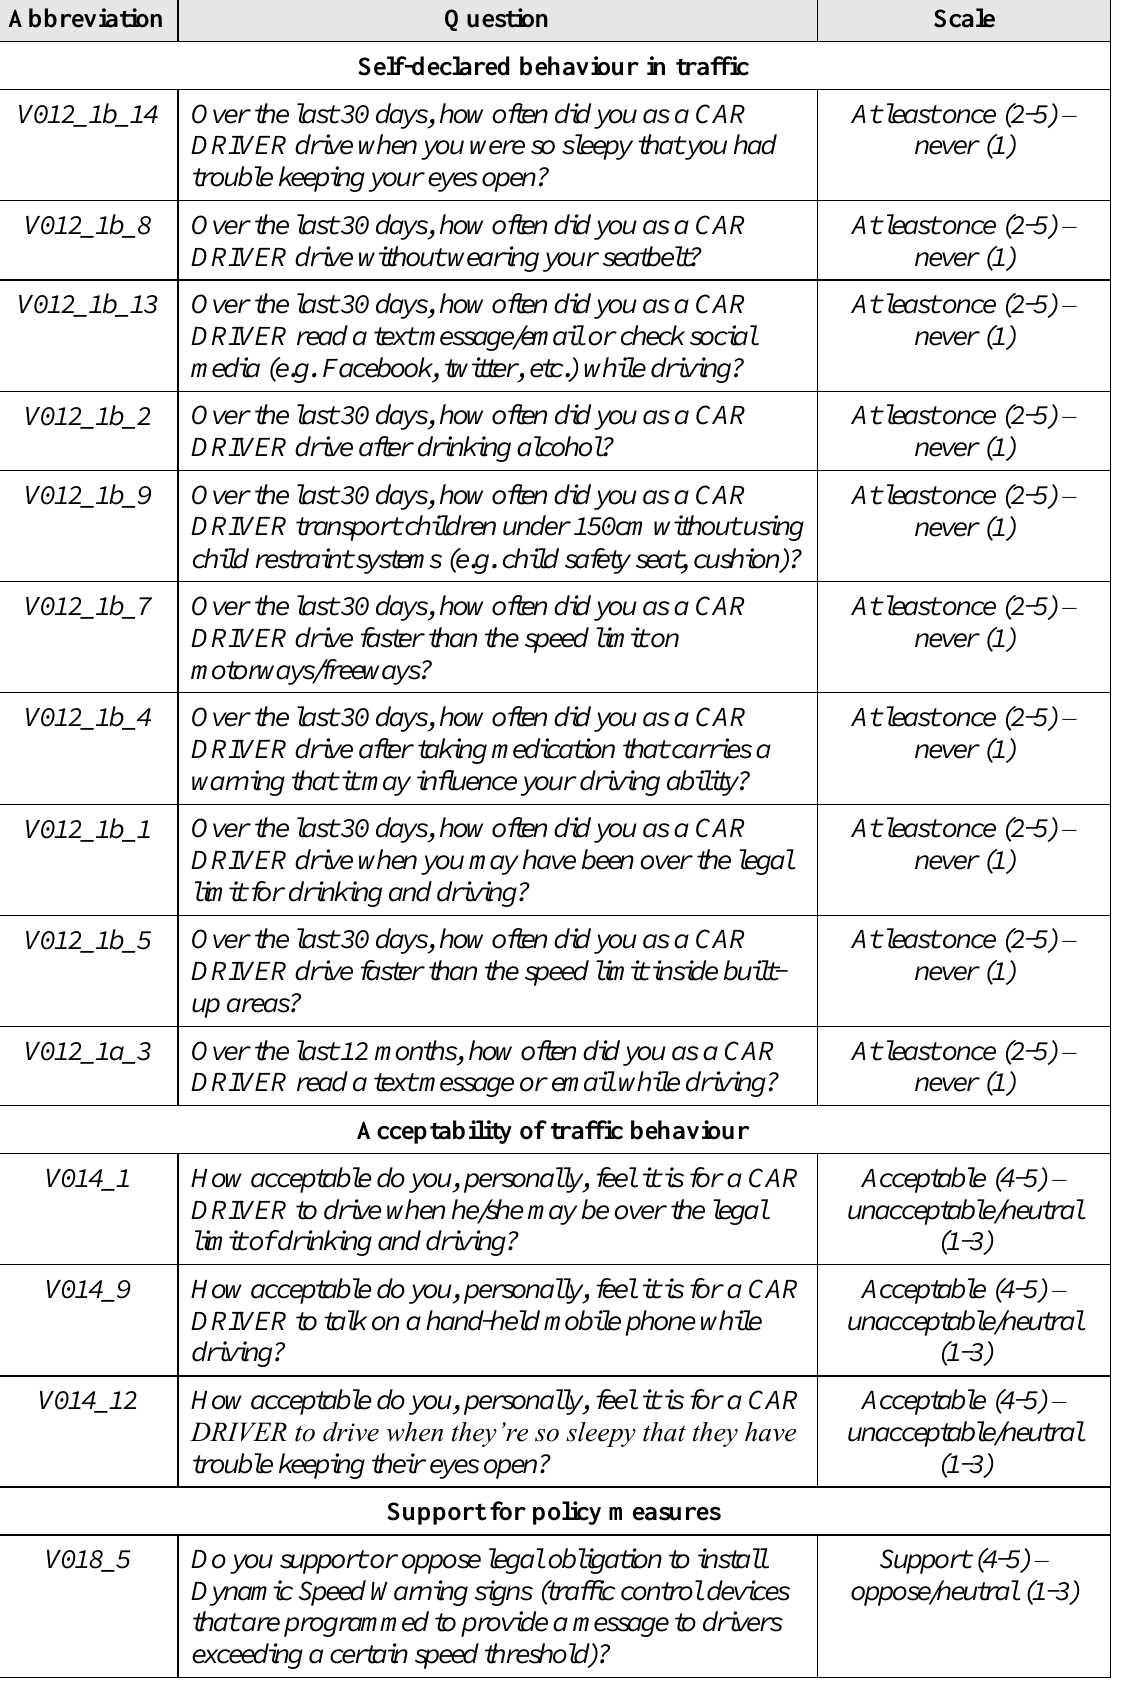
Table 1. Considered variables from the ESRA2